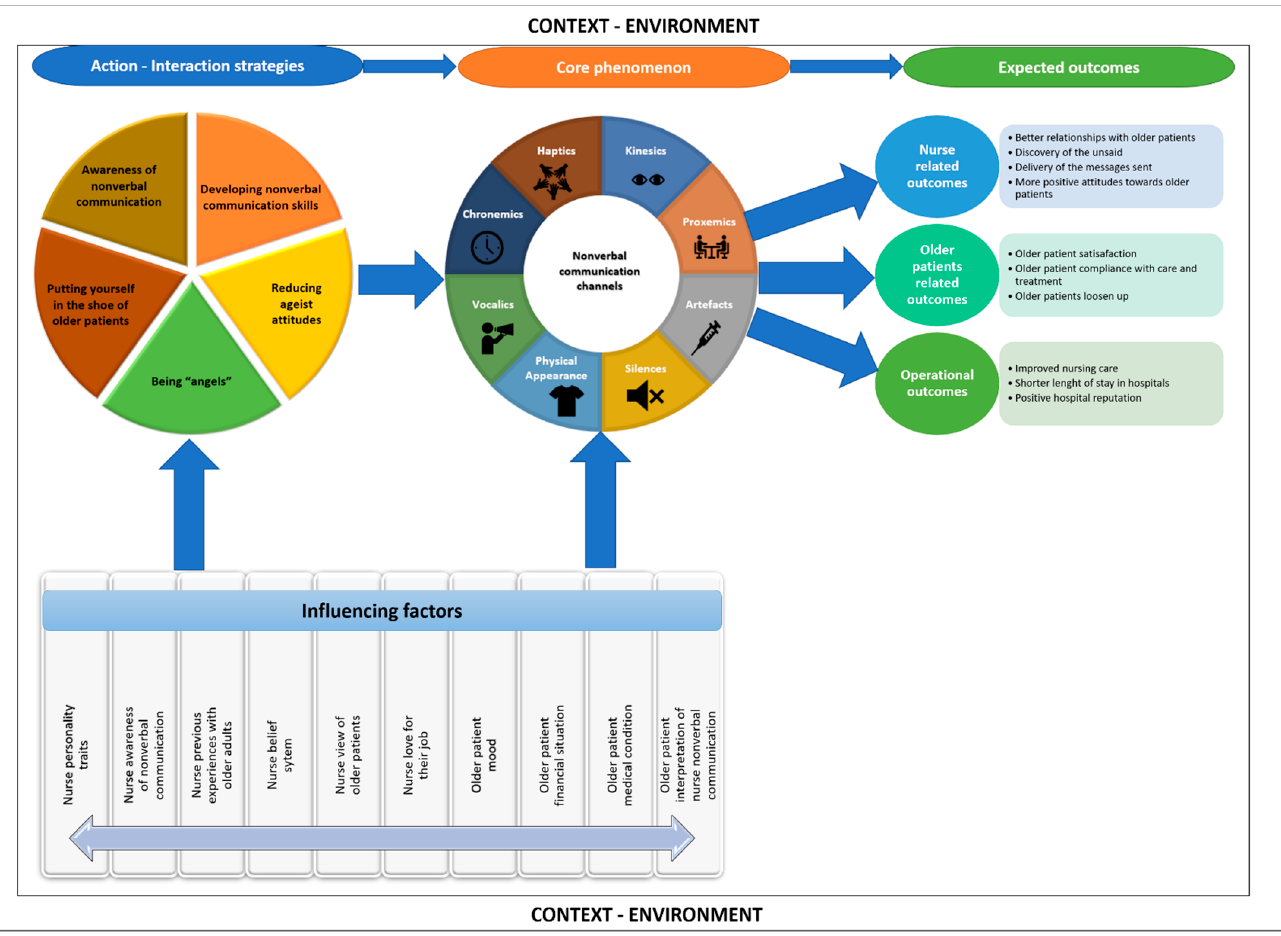
Figure 2. A model for effective nonverbal communication with older patients.